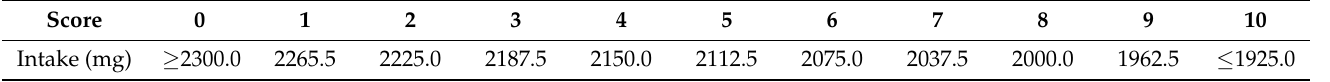
Table 3. Summary of score correspond to Sodium intake (mg).